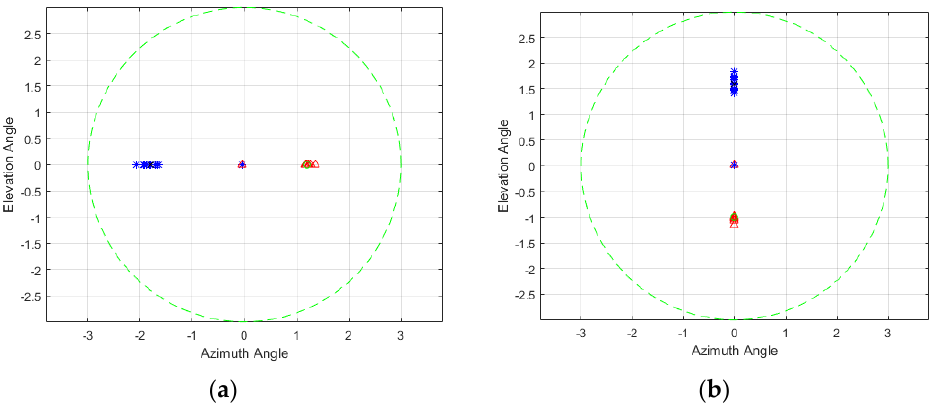
Figure 6. Scatter plot of angle estimates of real target and decoy (decoy ( Δ ) and real target (*); ground truth locations of decoy (O) and real target (x)). ( a ) same elevation; ( b ) same azimuth.